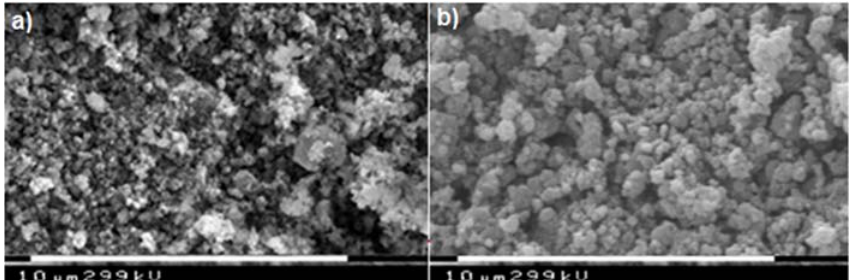
Figure 5. SEM images of LiFe 0.9 Mn 0.1 PO 4 : ( a ) sample S1 : P1/ Li 2 CO 3 ; and ( b ) sample S2 : ( P2 : P3 = 0.9:0.1)/Li 2 CO 3 . Materials 2018 , 11 , 56